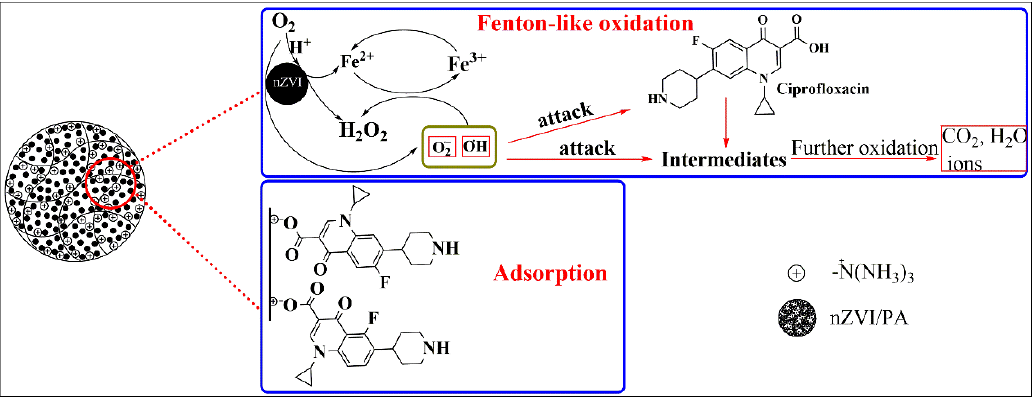
Figure 8. The reaction mechanism of CIP removal by nZVI/PA composites.